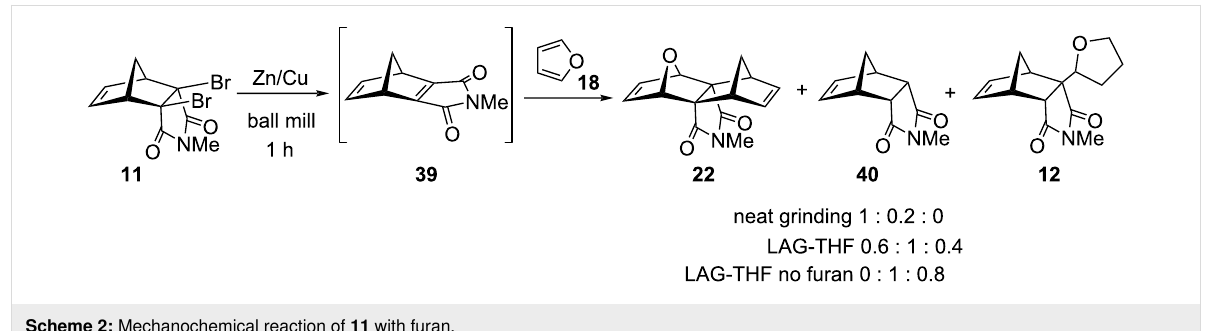
Scheme 2: Mechanochemical reaction of 11 with